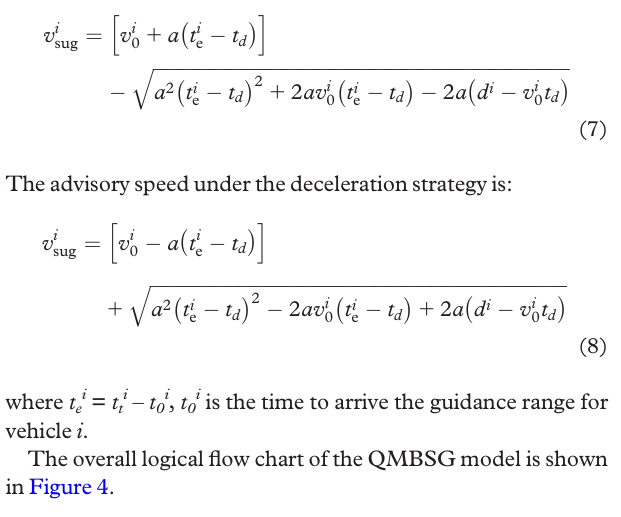
Figure 3 Diagram of guidance strategy of the QMBSG model